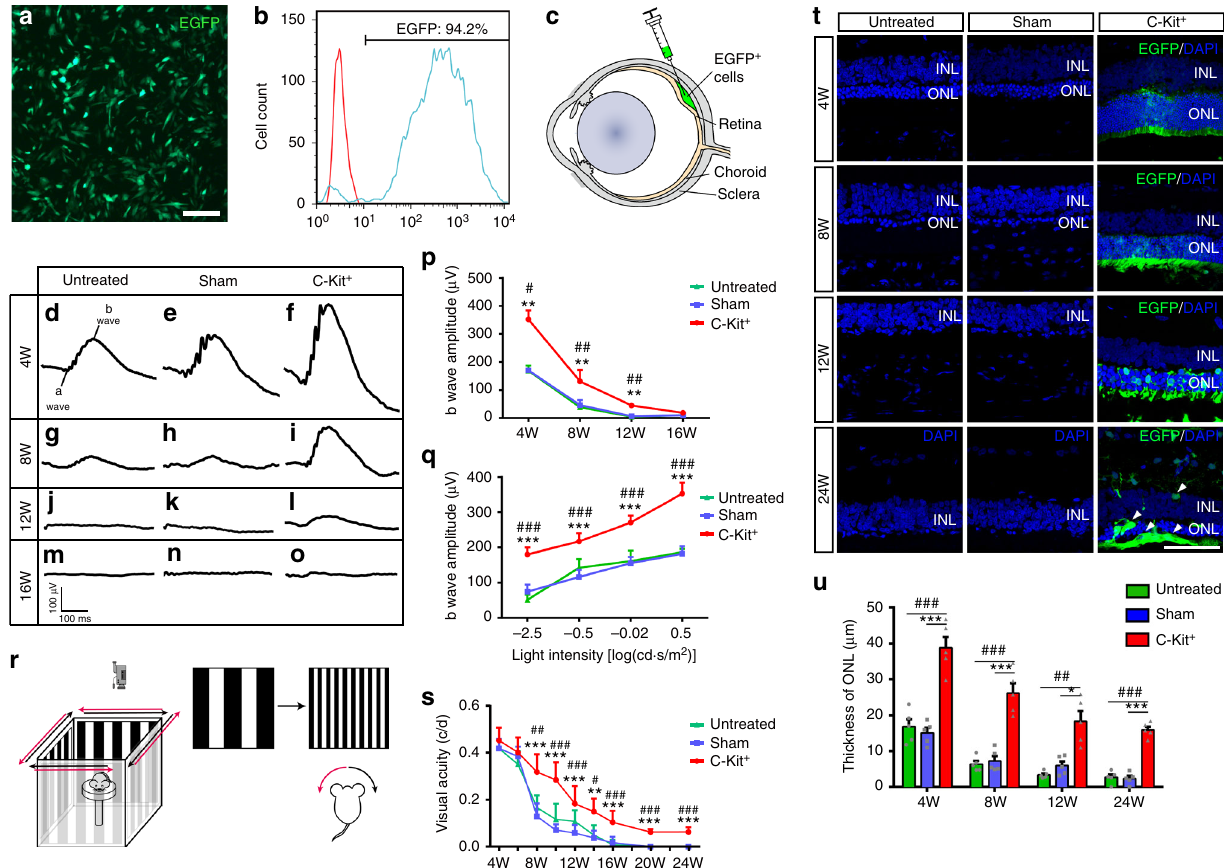
Fig. 4 Protective effect of grafted C-Kit + cells on RCS rats. a Identi fi cation of P3 EGFP hERO-derived cells transduced with lentivirus. b Flow cytometry analysis showing the EGFP + rate of P3 hERO-derived cells. c Diagram showing the subretinal transplantation. d – o Representative b-waves of the C-Kit + , sham, and untreated groups at PO 4w, 8w, 12w, and 16w measured through scotopic fl ash electroretinography (fERG) at 0.5 log(cd*s/m 2 ). p Statistical analysis of the amplitudes of ERG b-waves at 0.5 log(cd*s/m 2 ) in the three groups from PO 4 – 16w. n = 5 eyes/group. q ERG b-waves of different light intensity stimuli at PO 4w. n = 5 eyes/group. r Diagram showing the setup of the optokinetic response test. s Visual acuity analysis obtained through the optokinetic response test at various post-operational times up to 24 weeks. n = 6 eyes/group. t Representative images of the ONL in the three groups from PO 4 – 24w. EGFP + cells showing surviving cells at PO 24w (white arrowheads). u Statistical analysis of ONL thickness in the three groups at four time points ( n = 5 eyes/group). P values were determined by one-way analysis of variance (ANOVA) test followed by Tukey (equal variances) or Dunnett ’ s T3 (unequal variances) multiple comparison tests p , q , s , u C-Kit + cells vs Sham: * P < 0.05, ** P < 0.01, *** P < 0.001; C-Kit + cells vs Untreated: # P < 0.05, ## P < 0.01, ### P < 0.001. Data are presented as mean ± SEM. Scale bars, 100 μ m ( a ), 50 μ m ( t ). ONL outer nuclear layer, INL inner nuclear